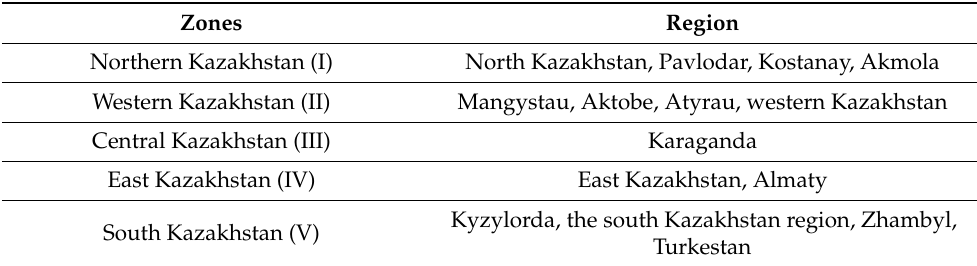
Table 1. Main zones of territorial division of Kazakhstan.